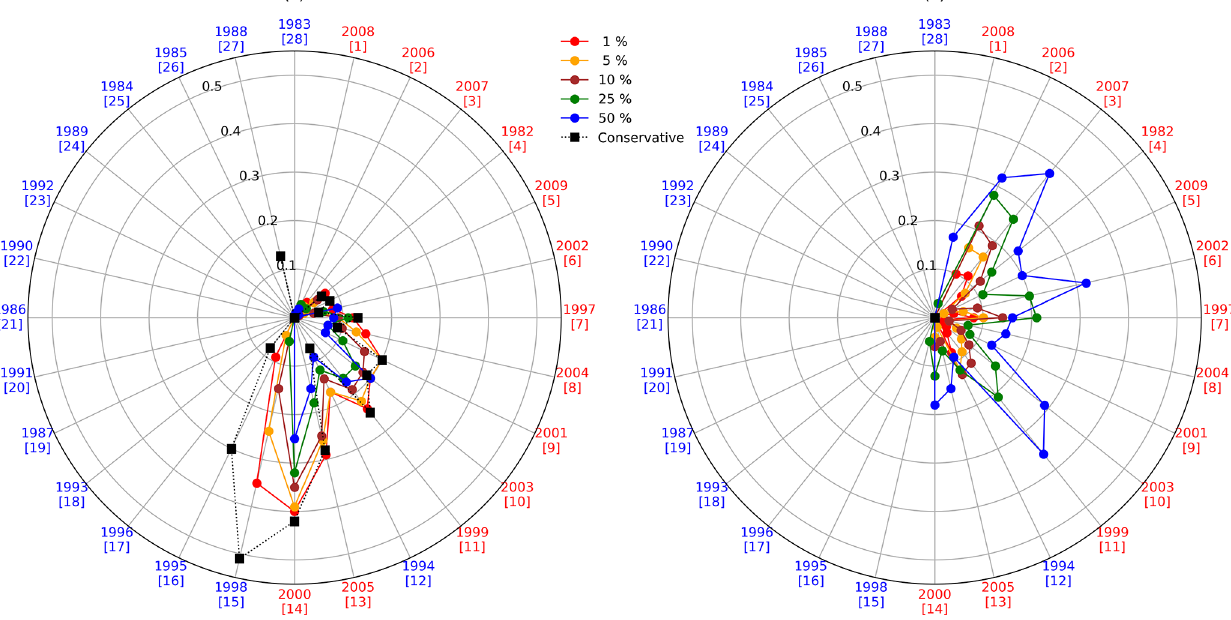
Figure 11. Inconsistency for all 28 years using FoGSS/POAMA forecast updated every month to inform the allocation decision. (a) shows the annual inconsistency due to upward revisions (positive inconsistency) and (b) the annual inconsistency due to downward revisions (negative